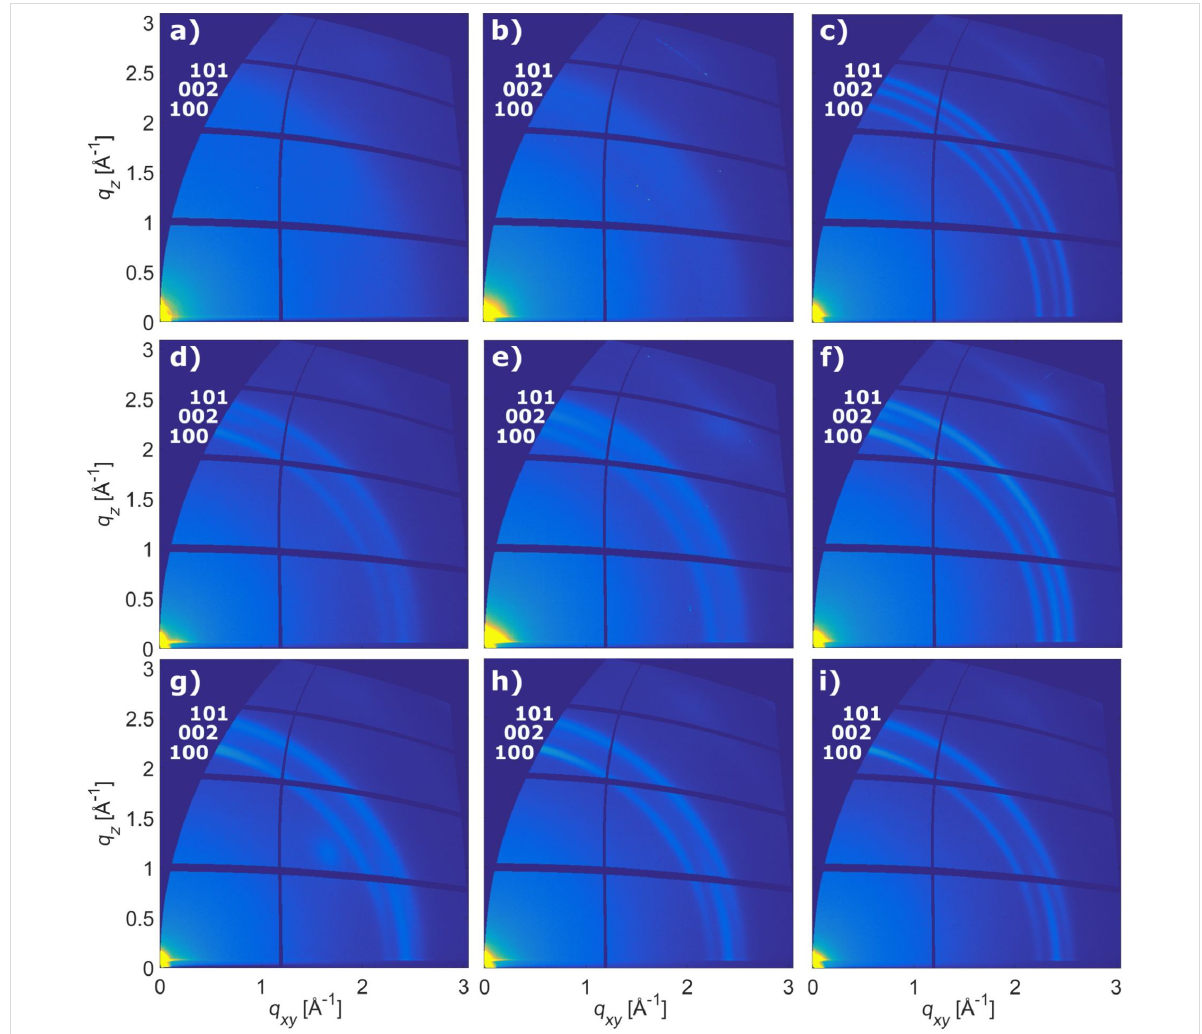
Figure 5: GIXD maps for the zincone-like layers deposited at different plasma times before and after annealing at different temperatures: 1 s plasma exposure time a) 25 °C, b) after 200 °C calcination, c) after 400 °C calcination; 2 s plasma exposure time d) 25 °C, e) after 200 °C calcination, f) after 400 °C calcination; 4 s plasma exposure time g) 25 °C, h) after 200 °C calcination, i) after 400 °C